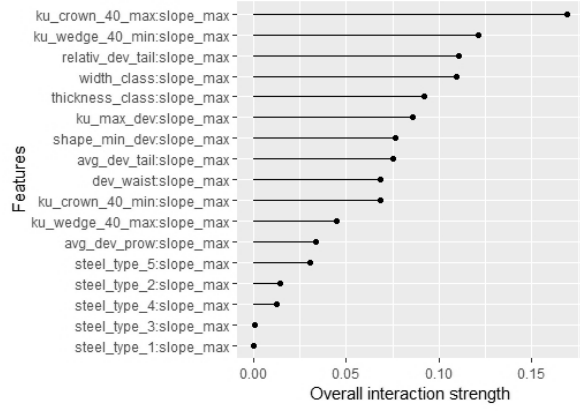
Figure 8: The overall interaction strength (H-statistic) for each feature independently.